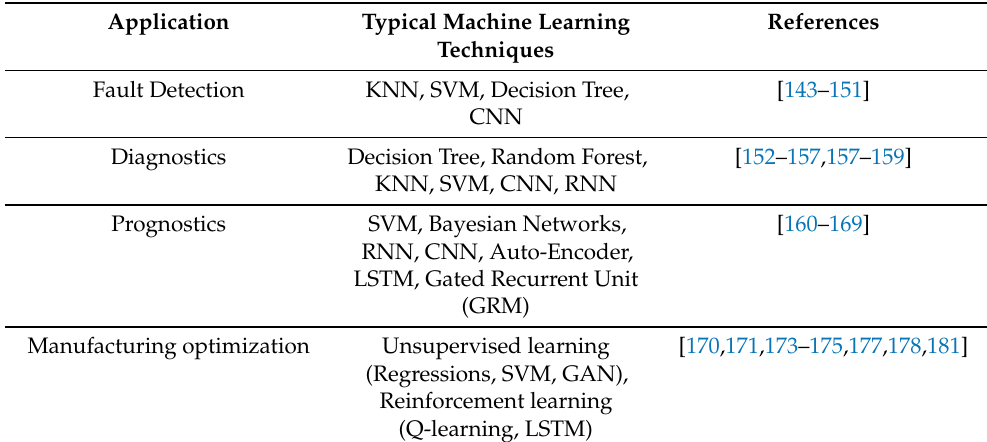
Table 4. Summary of applications of machine learning techniques in IIoT proactive